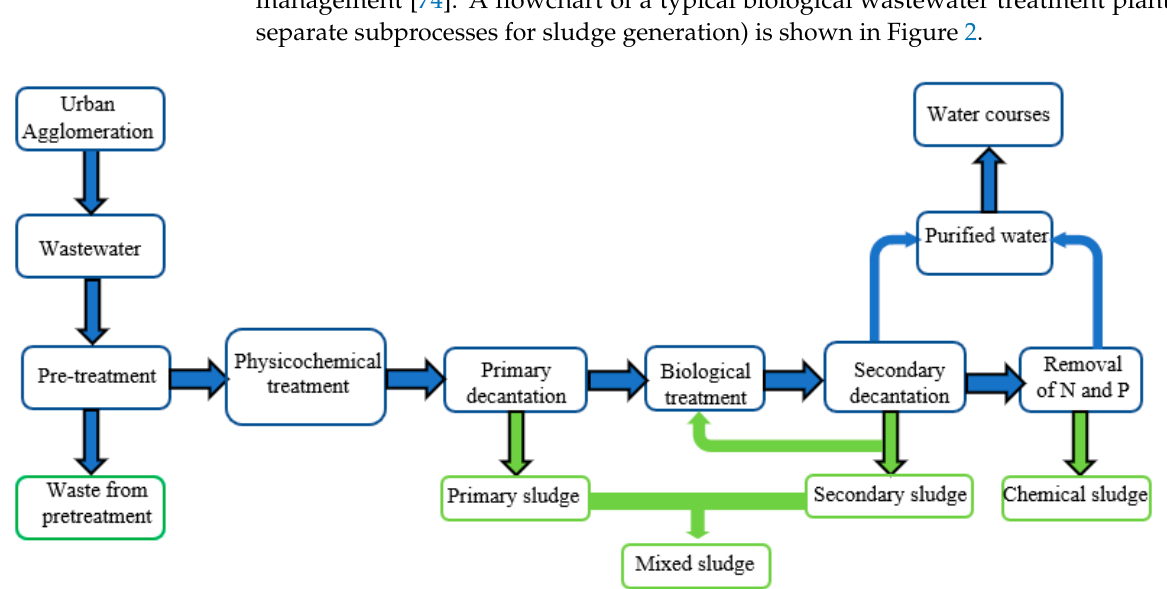
Figure 2. Biological wastewater treatment plant with separate sludge generation subprocesses. N—nitrogen; and P—phosphorus.